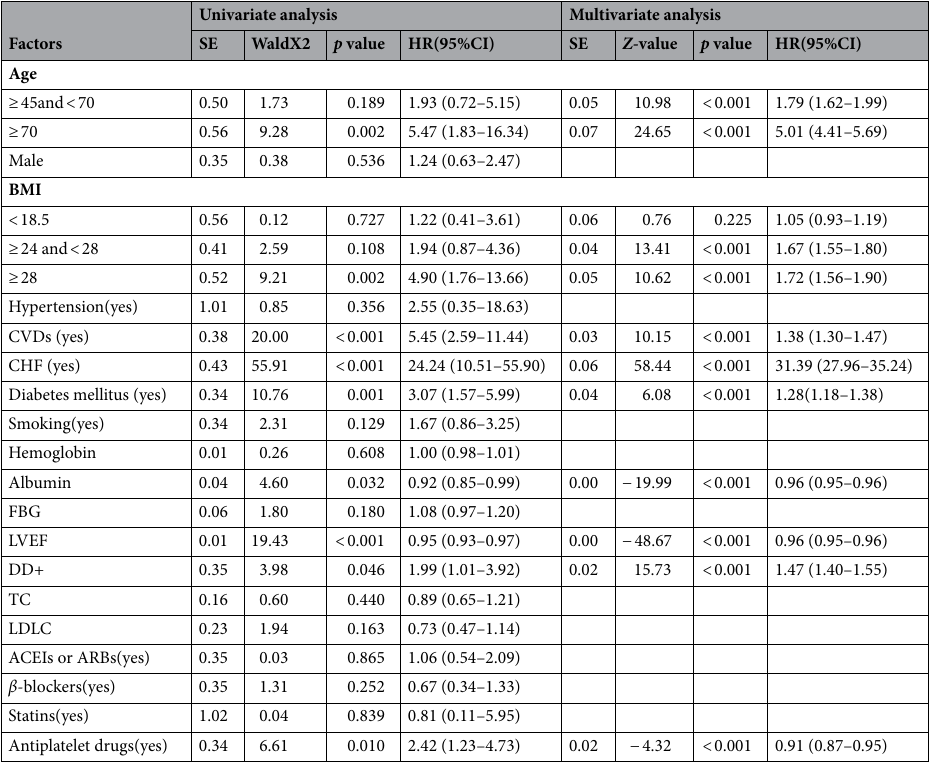
Table 3. Univariate analysis by Cox proportional hazard analysis and multivariate analysis by bootstrap for LSCEs as the endpoint. SE, standard error; HR, hazard ratio; CI, confidence interval; BMI, body mass index; CVDs, cardiovascular diseases; CHF, chronic heart failure; FBG, fasting blood glucose; LVEF, left ventricular ejection fraction; DD+, diaphragm dysfunction; TC, total cholesterol; LDLC, low density lipoprotein cholesterol; ACEIs, angiotensin converting enzyme inhibitors; ARBs, angiotensin receptor